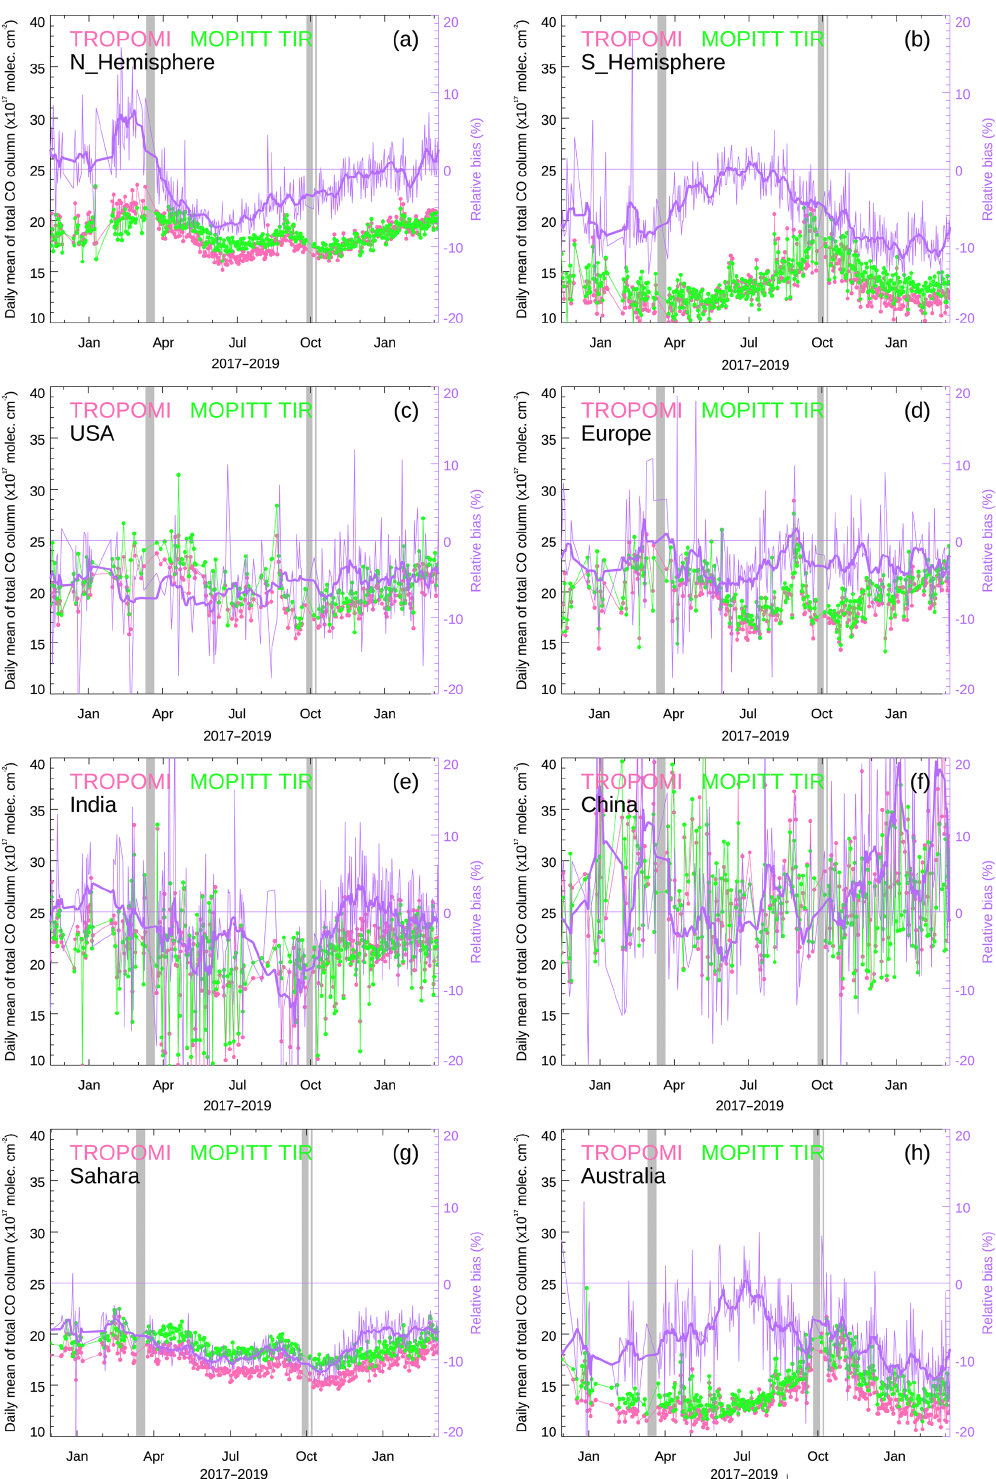
Figure 3. Comparison of colocated land retrievals from TROPOMI (pink) and MOPITT TIR (green) for each ROI analyzed. Filled circles show the daily mean. Thin purple lines indicate the daily relative bias (i.e., accuracy) between the two datasets, and thick purple lines are an 11d smoothed version with high-frequency variability removed. Gray bars show periods without MOPITT measurements because of